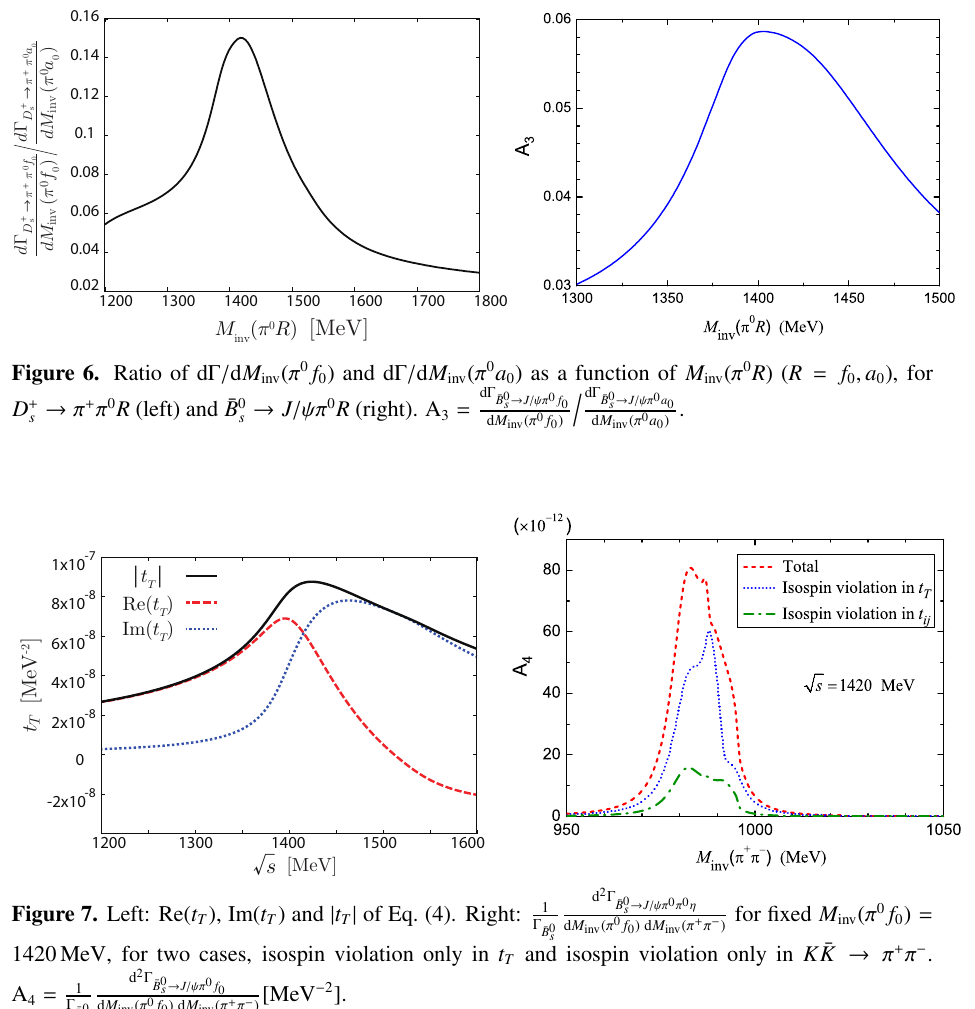
Figure 7. Left: Re( t T ), Im( t T ) and | t T | of Eq. (4). Right: 1 Γ 1420MeV, for two cases, isospin violation only in t T and isospin violation only in K ¯ K → π + π − . d 2 Γ ¯ B 0 s → J /ψπ 0 f 0 A 4 = 1 Γ [MeV − 2 d M inv ( π 0 f 0 ) d M inv ( π + π − ) ¯ B 0 s